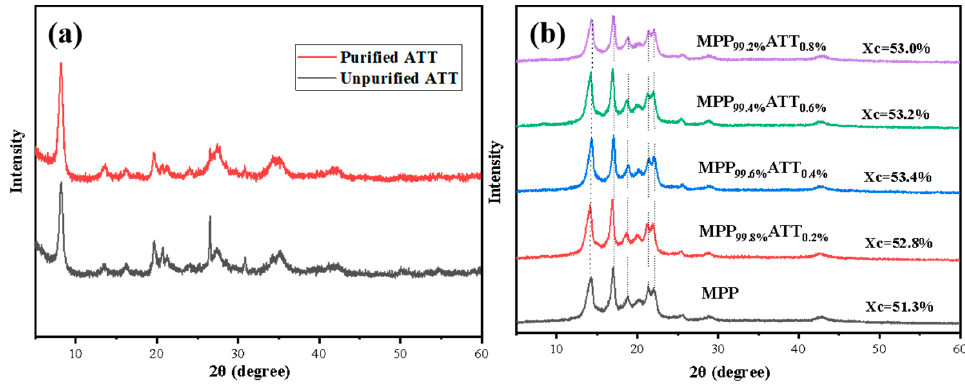
Figure 5. Diffraction peak intensity diagram. ( a ) purified and unpurified ATT; ( b ) MPP and MPP/ATT nanocomposites with different amounts of ATT.